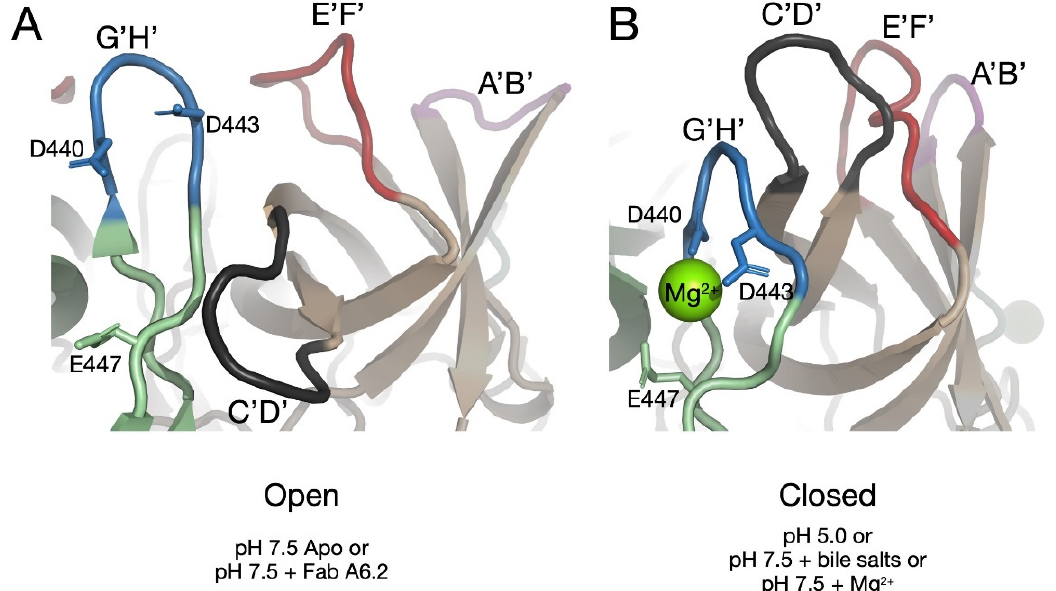
Figure 4. Environmentally driven changes in the G’H’ loop may control the P domain conformation. Shown here are ribbon diagrams of the tip of the P domain with the same color scheme as the previous figures. ( A ) There are three acidic groups on the G’H’ loop (D440, D443, and E447). At a pH of 7.5, these are expected to be deprotonated and therefore charged and repulsive. Indeed, under these conditions, the more vertical conformation of the loop allows the acidic sidechains to be well separated [31,37]. In this position, there is now room for the C’D’ loop to be in the downward conformation and thus allowing the A’B’/E’F’ loops to be in the open conformation. ( B ) At acidic conditions [20] or at neutral pH but in the presence of metals [40], these acidic groups are allowed to move into proximity and cause the G’H’ loop to distort, filling the space normally occupied by the C’D’ loop. This starts a chain reaction that leads to the closed conformation of the P